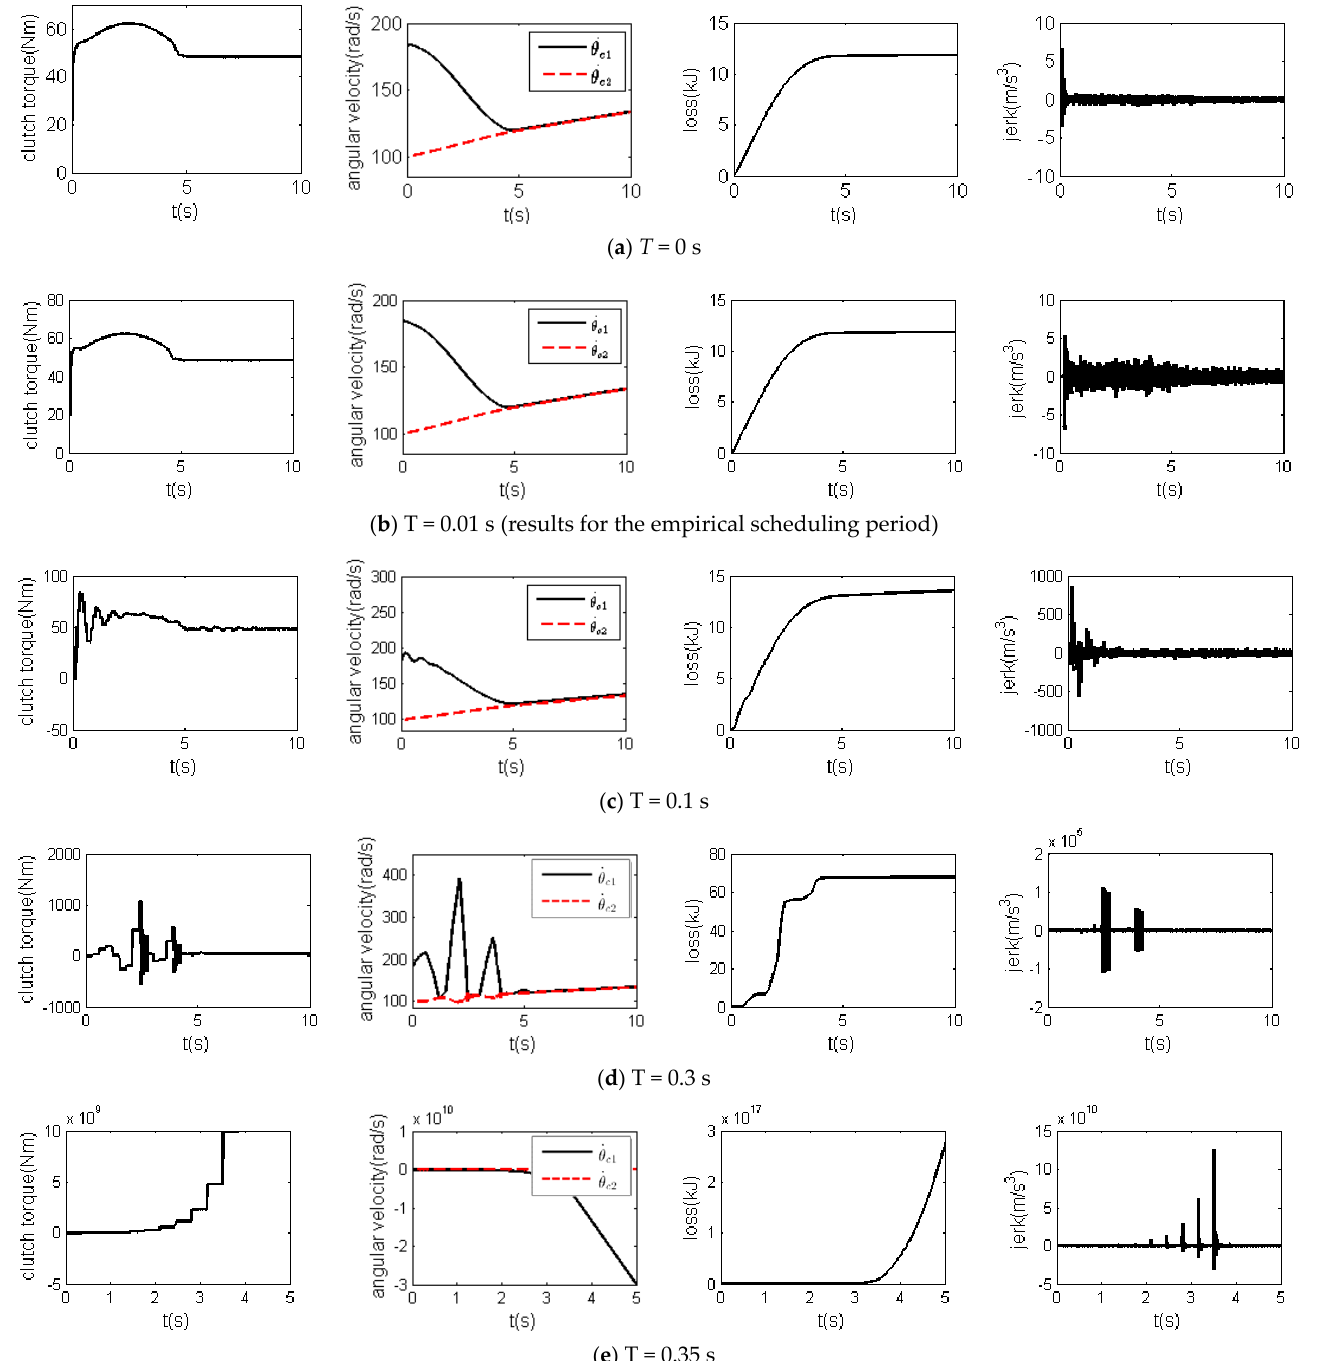
Figure 8. Dynamic responses under different task scheduling periods.